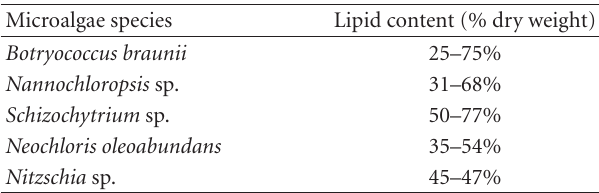
Table 2: Lipid content of selected algae species